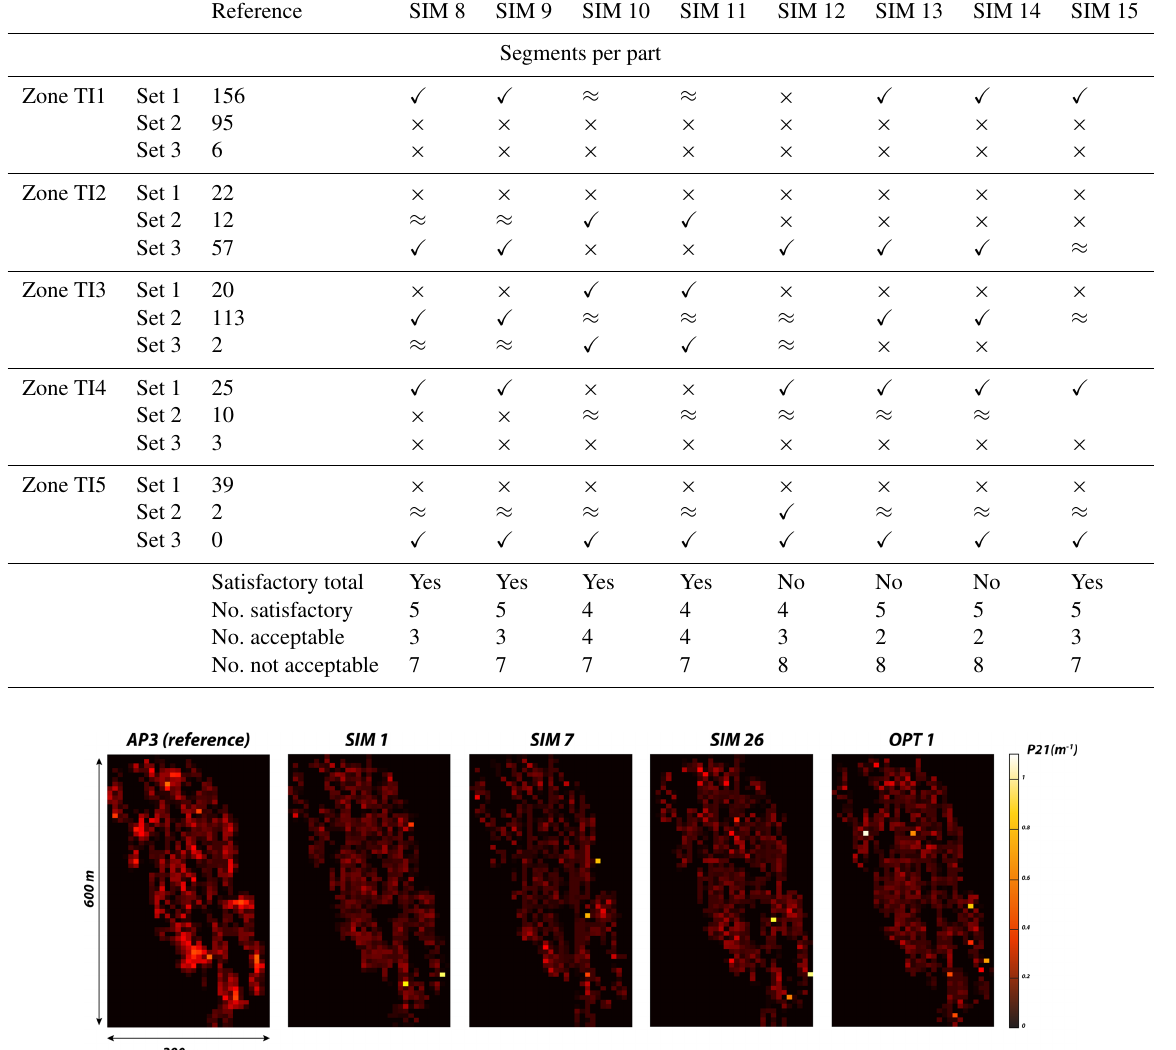
Figure 10. Comparison of the fracture intensity ( P 21 ) calculated in the reference outcrop and in four select MPS